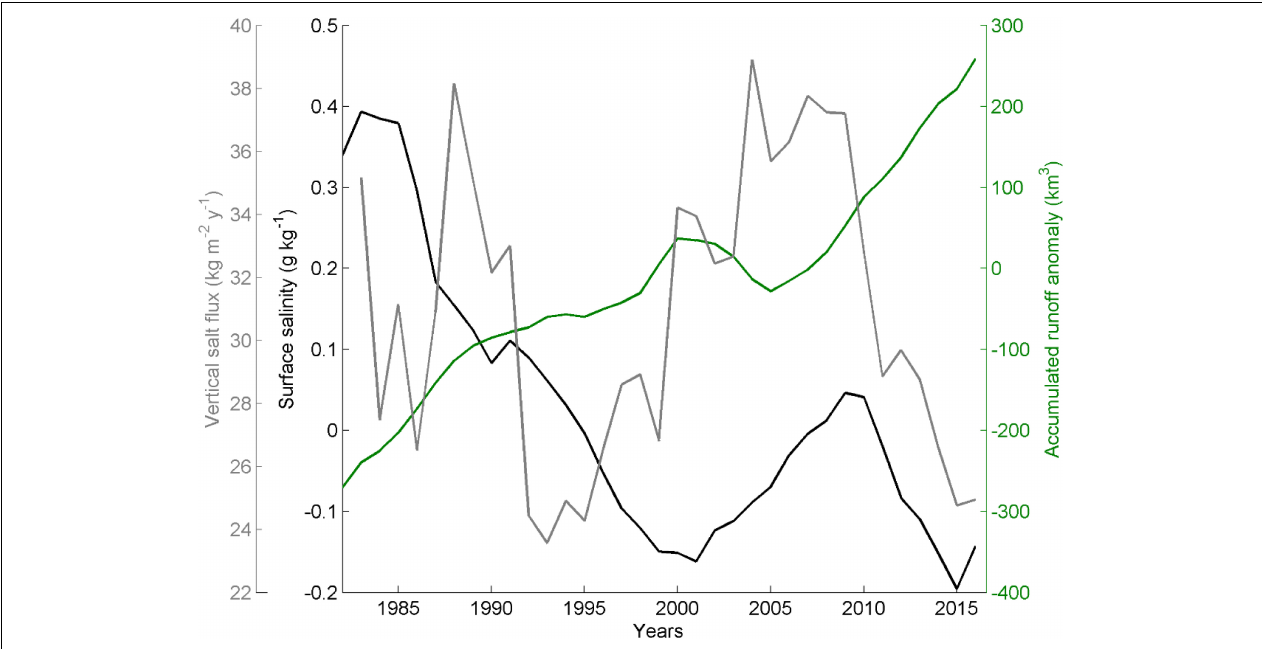
FIGURE 9 | Smoothed (by cut-off period 5 years) time-series of surface salinity anomalies in the Eastern Gotland Basin, accumulated river runoff anomalies, and vertical salt flux. River runoff data from Johansson (2018) were